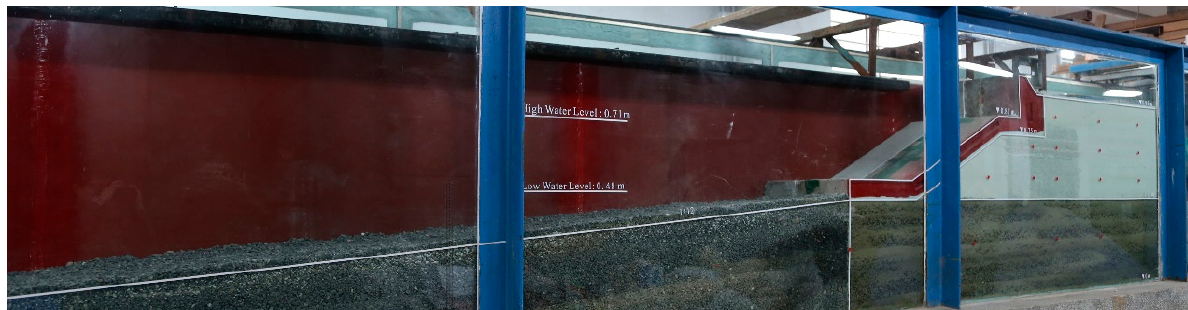
Figure 3. A real view of the completed physical model without accropodes or rubble in front of the revetment breakwater.